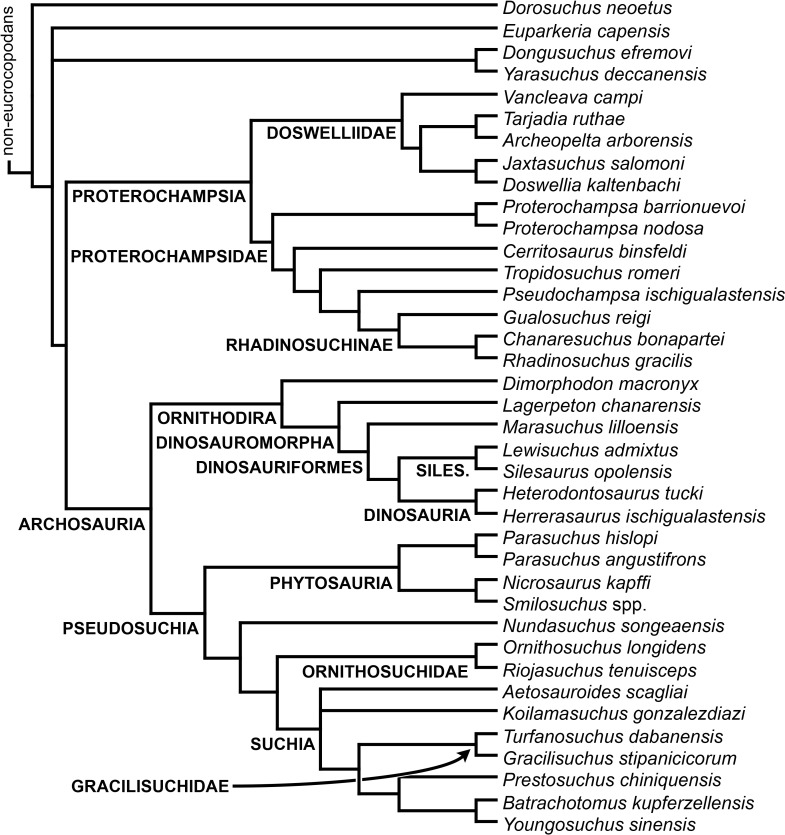
Strict reduced consensus tree recovered from analysis 3 showing the phylogenetic relationships of eucrocopodan archosauromorphs after the a posteriori pruning of Kalisuchus rewanensis and Asperoris mnyama.Non-eucrocopodan diapsids are not skown in this tree.